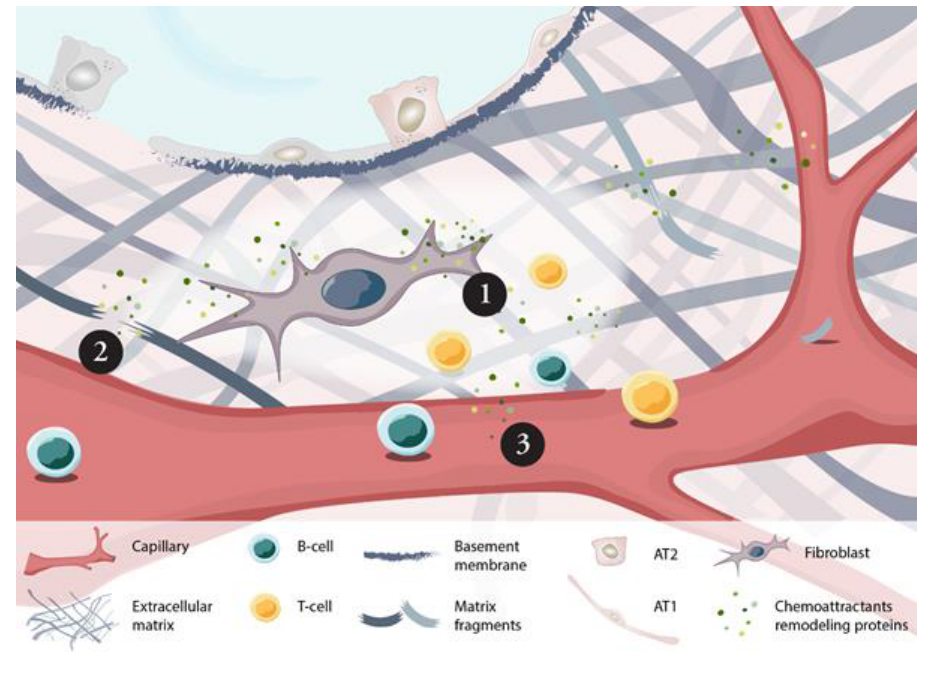
Figure 7. Proposed mechanism of local fibroblast activity in IPF lung revealed in patient serum. In distal lung tissue of IPF patients, fibroblasts become activated by the surrounding fibrotic-ECM triggering a profibrotic phenotype releasing elevated levels of chemoattractants (e.g., CCL19, CXCL13) for the recruitment of immune cells (1), and of remodeling proteins (e.g., MMP7) (2). The released factors alter ECM turnover, influencing the integrity of epithelial and vascular basement membranes facilitating and cellular invasiveness and responses in the tissue. Fibroblast-ECM interplay renders a systemic fingerprint in serum of IPF patients (3) that correlate to disease severity and ongoing local tissue remodeling processes in the lung.